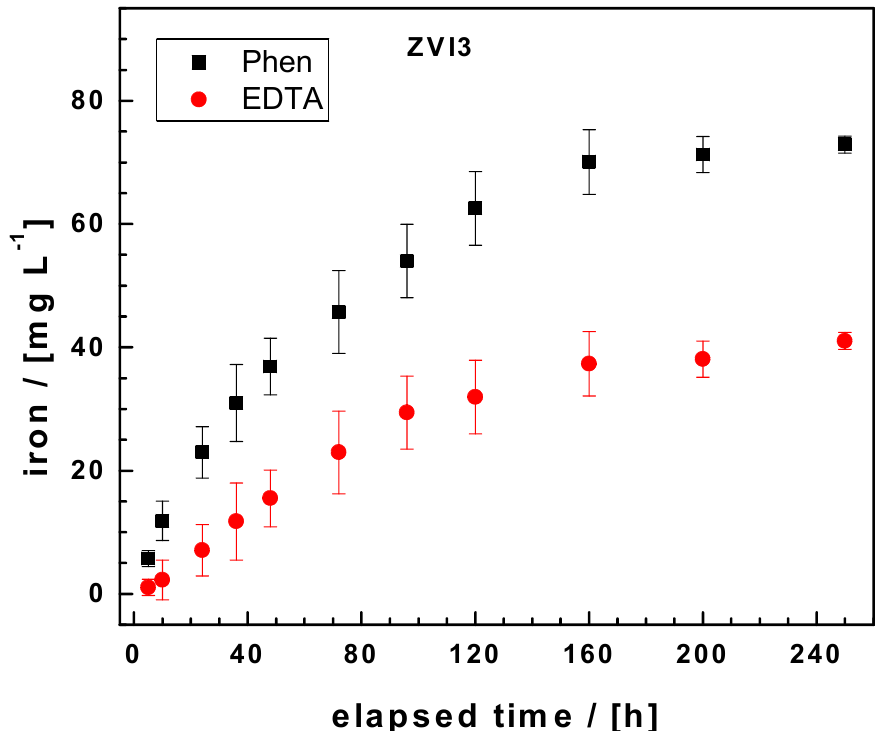
Figure 2. Iron dissolution from ZVI3 by 2 mM EDTA and 2 mM Phen under quiescent conditions for 10 days (250 h). Error bars denote the standard error for triplicate experimental results. Experimental conditions: V = 50 mL, m ZVI = 0.1 g.